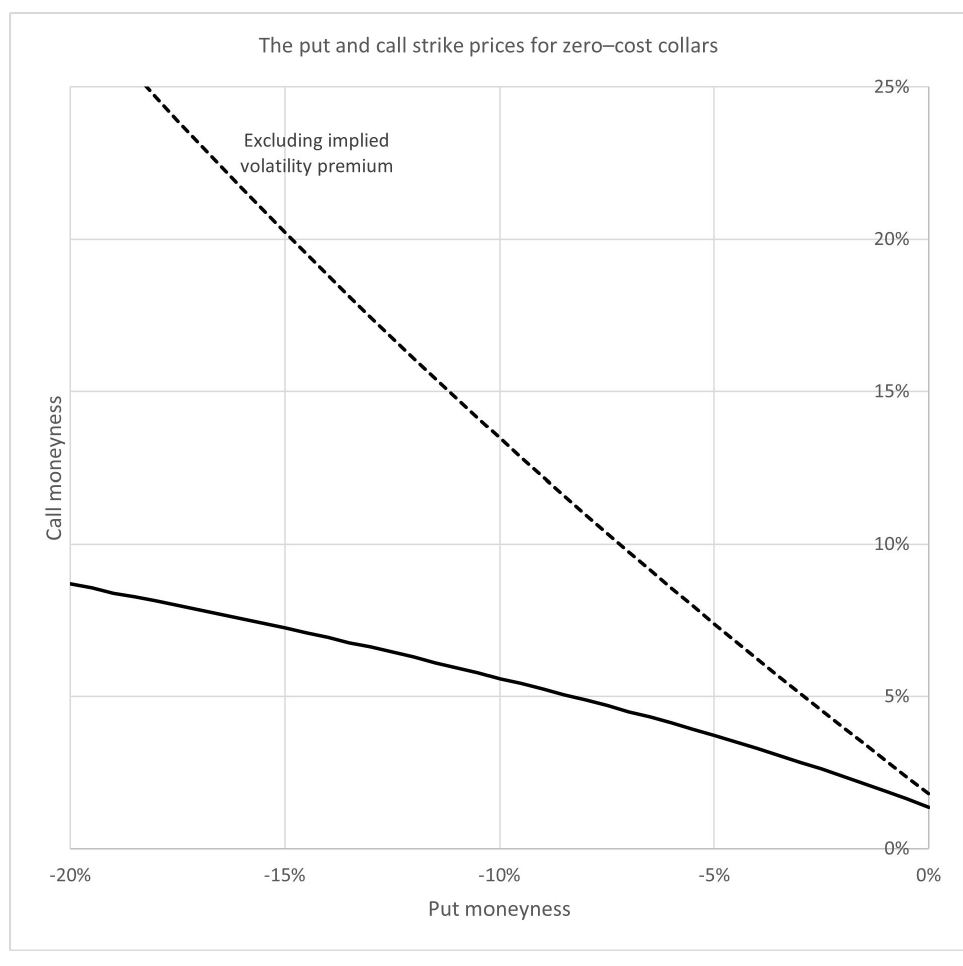
Figure 14. The strike price of a call such that a collar has zero initial cost for a range of put strike prices. The dotted line assumes the implied volatility is equal to the underlying asset volatility. The solid line uses includes the implied volatility premium in the price of the options. The put is more expensive when incorporating the volatility skew, so more capital appreciation must be sacrificed, resulting in a lower call strike